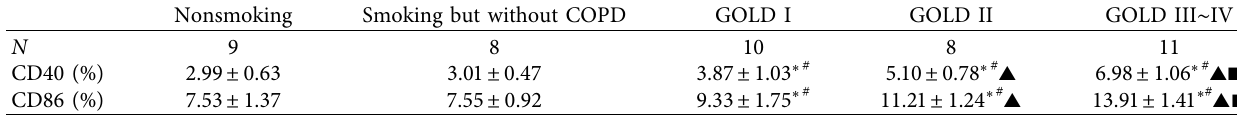
Figure 1: The results of CD40 and CD86 in healthy individuals and COPD patients. The expression of CD40 and CD86 were analyzed by FCM (left for the control tube, right for the test tube), including nonsmoking group (a), smoking but without COPD group (b), GOLD I group (c), GOLD II group (d), and GOLD III-IV group (e). Table 3: Expression of CD40 and CD86 in different